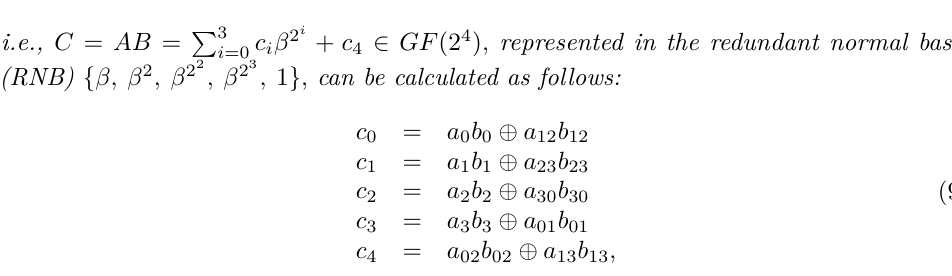
Figure 2: The proposed S-box